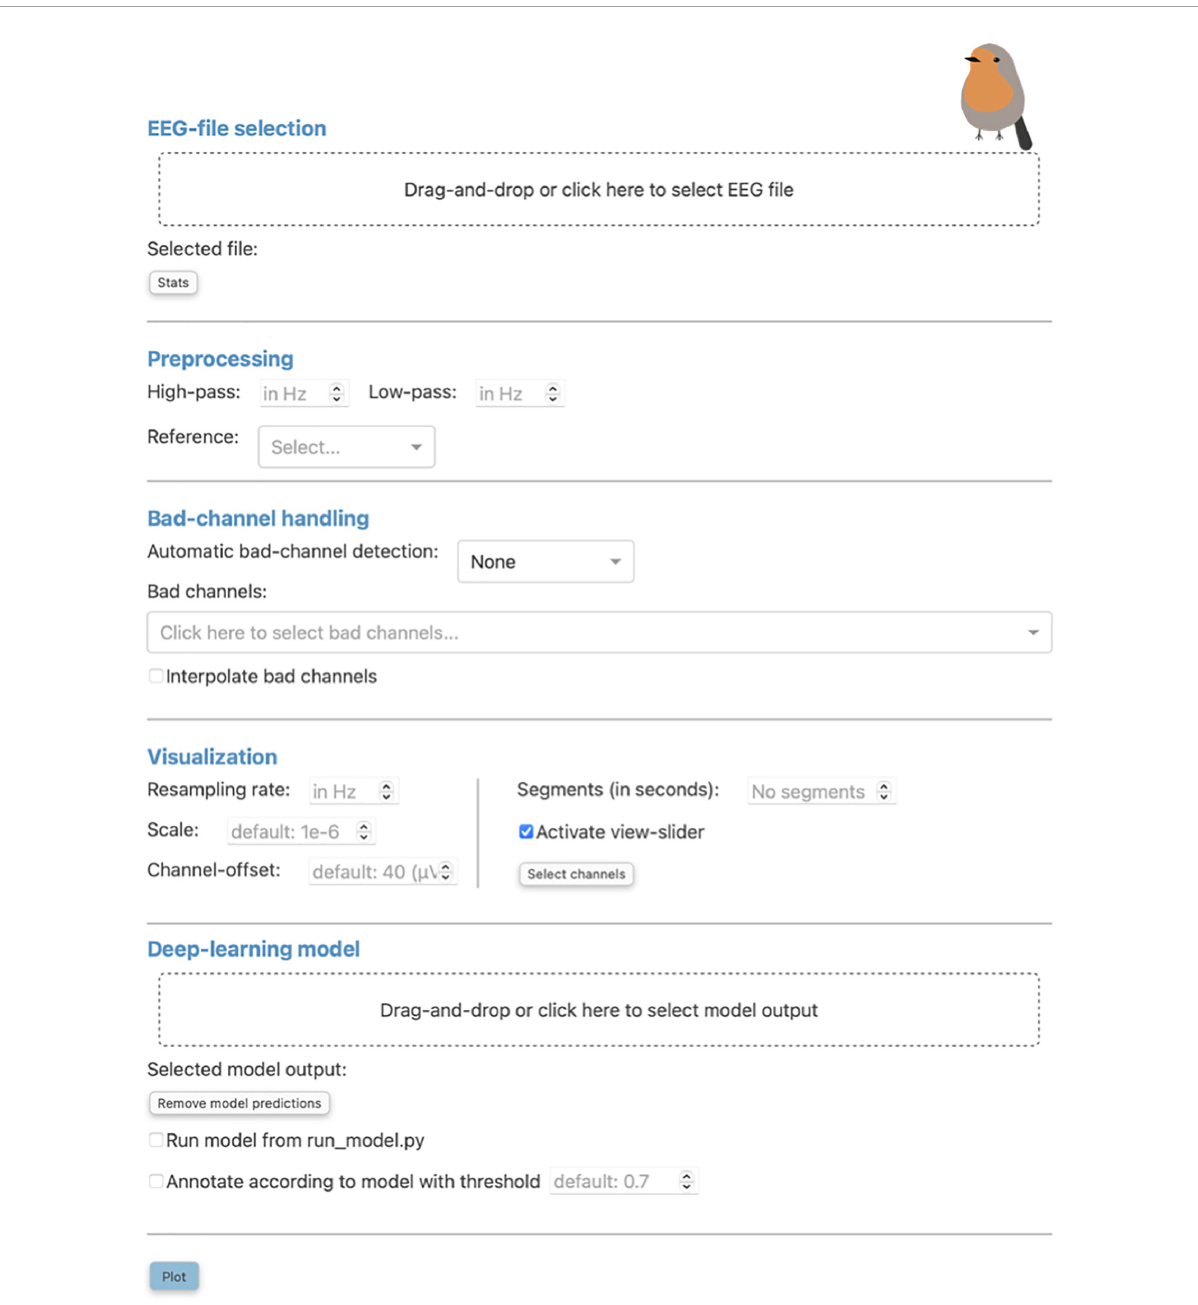
FIGURE1 The “Preprocessing” pop-up window is the initial screen of Robin’s Viewer (RV) and has five distinct sections: First, the electroencephalography (EEG)-file selection (see Section “3.1 Loading EEG data”), where the user can load their EEG recording and display selected statistics about the data once it is loaded. Second, the preprocessing settings (see Section “3.2 Preprocessing and visualization settings”), which are used to set a bandpass filter [finite impulse response (FIR) filter with Blackman window] and a custom reference. Third, the bad-channel handling (see Sections “3.2 Preprocessing and visualization settings” and “3.4 Bad-channel marking”), where the user can decide whether to use automatic bad channel detection, and whether to interpolate bad channels. Fourth, the visualization settings (see Section “3.2 Preprocessing and visualization settings”), comprised of downsampling, custom scaling (by default 1e-6 as RV scales data from volts to microvolts for plotting), the gap between traces (by default 40 ( µ V); setting this to 0 results in butterfly mode where all traces are collapsed on top of each other; values higher than 40 move traces further apart), segment length to plot [by default 60 (seconds)], whether or not to activate the view-slider, and selection of channels to plot. Visualization settings will only be applied to the data for plotting and hence will not be saved in the save-file (in contrast to the preprocessing settings). Fifth, the deep-learning model settings (see Sections “3.2 Preprocessing and visualization settings” and 3.5 Deep-learning model predictions”), where previously saved model output can be loaded and the integrated deep-learning model can be activated to generate predictions. Clicking the “Plot” button at the bottom will close this window and, after a loading screen (which lasts as long as it takes to plot the data), it will open up the main graphical user interface